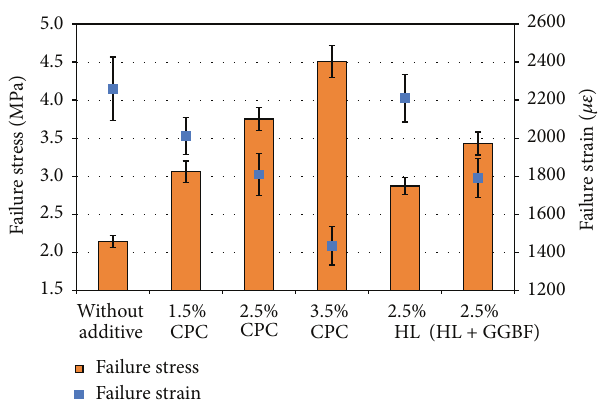
Figure 4: Failure stress and strain.